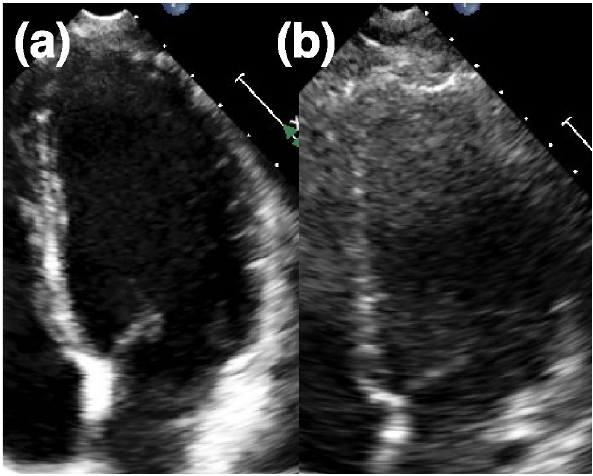
Figure 4. Demonstration of contrast-to-noise (CNR) differences for echocardiogram scans from clinical test subjects. ( a ) High CNR (> 8 dB), where there is little signal within the LV and strong tissue signal in the myocardium, composing the LV. ( b ) Low CNR (< 2 dB), where there is high, incoherent speckle noise within the LV and weak tissue signal along with signal loss within the myocardium composing the LV. These images were taken from two female subjects, one aged 21 years old (y/o) and the other aged 24